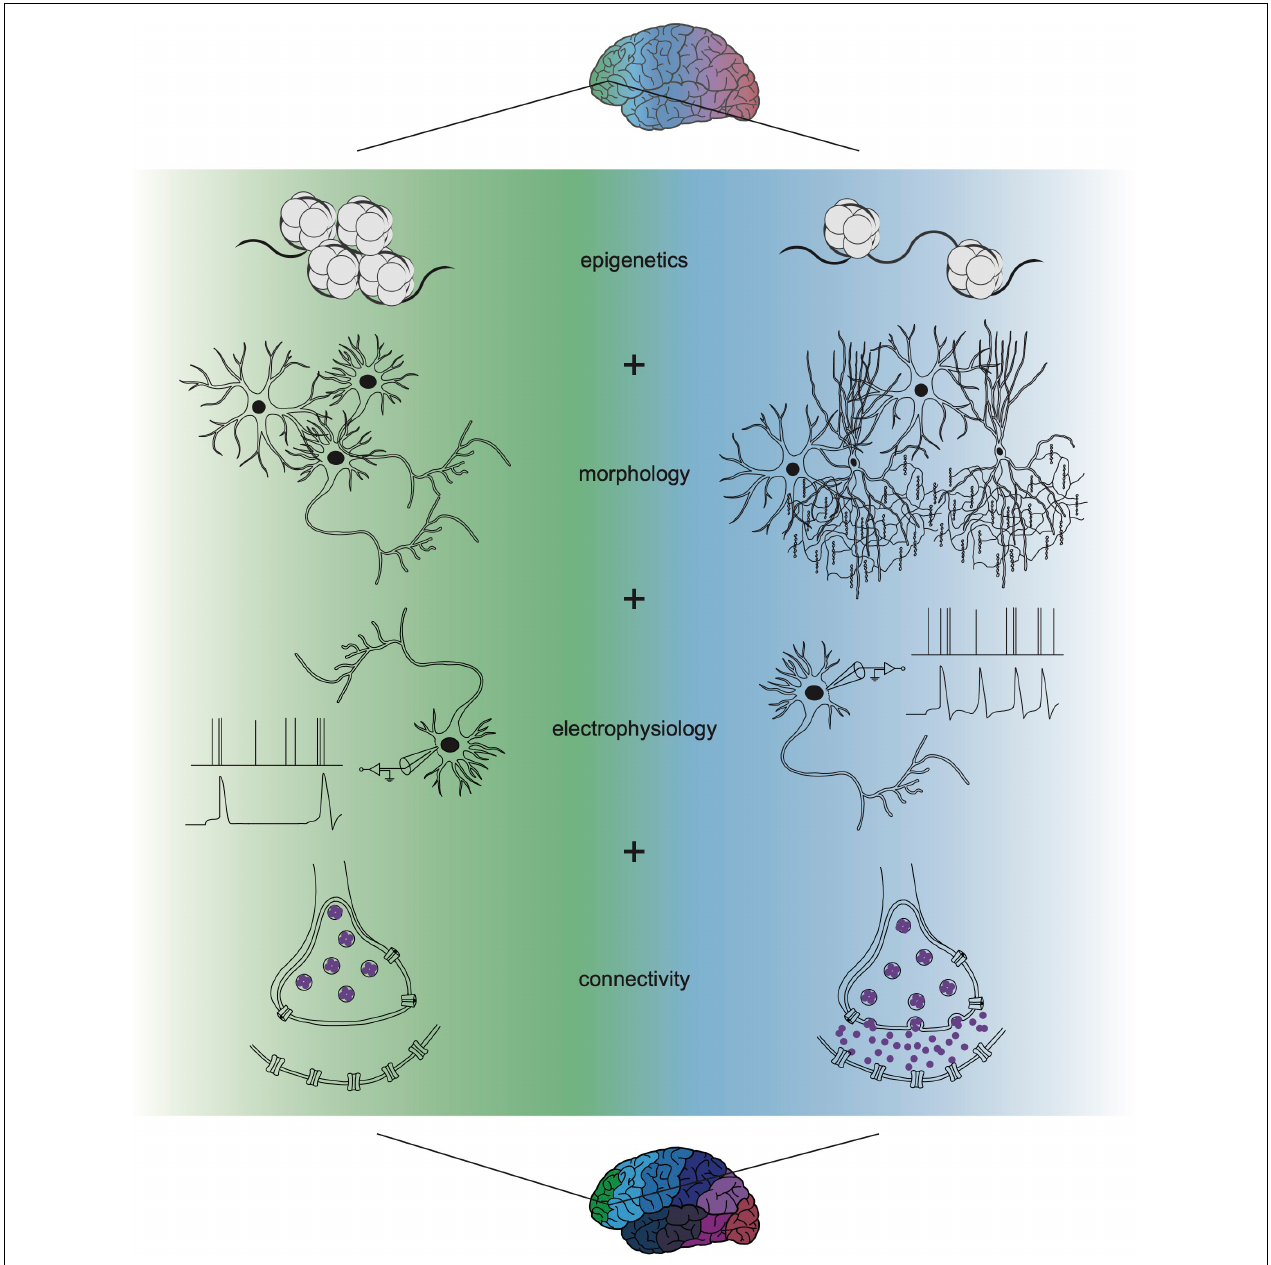
FIGURE 2 | Multi-omic single-cell approaches refine understanding of cortical cell function. Novel strategies applying the integration of transcriptomics with profiles of epigenetics, morphology, electrophysiology, and connectivity are refining areal differences in cell type above what can be elucidated from transcriptional identity alone. Transcriptional differences may initiate and propagate the onset of these other modalities, together resulting in discrete cell type and unique areal function. Recent multi-omic technological advances have already improved characterization of cell types and the field will continue to integrate more properties as we fully understand cortical cell biology. The identification of multi-omic states that integrate each of these functions will be needed to determine how such phenotypic distinctions generate stark functional specializations for cortical